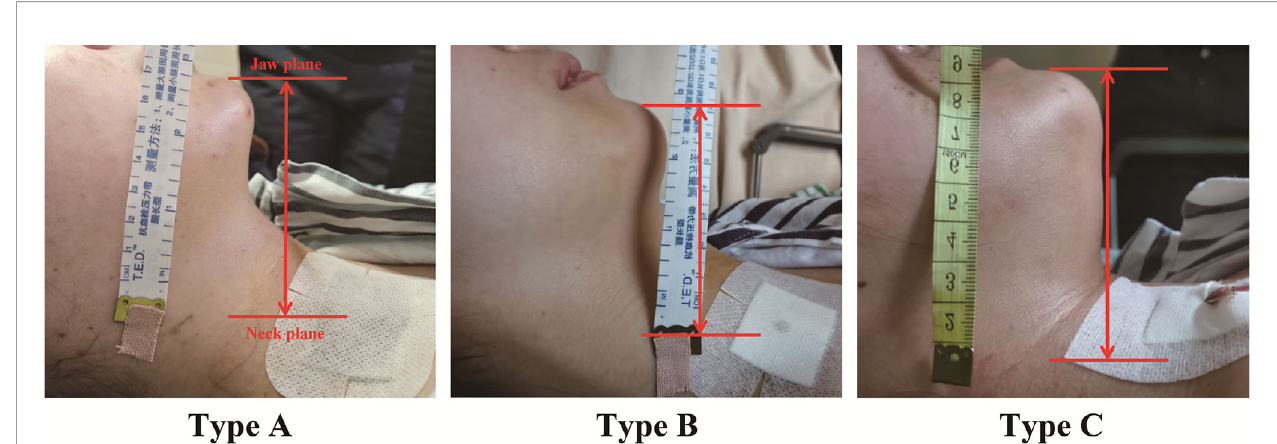
FIGURE 2 | The length of jay was measured from anterior neck plane to the anterior border plane of jaw (red line) in the three